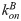
Relaxation kinetics of the AV-HABA complex and unlabeled biotin.The [HABA]/[B7] is the concentration ratio of these two ligands and the relaxation rate is in s-1 (Eq 3). The data points were fitted to a linear regression model yielding a slope and intercept of 0.0156 ± 0.0012 and 0.161 ± 0.005, respectively, resulting in a konB of 5.3 ± 0.9 × 106 M-1s-1 at 23°C. The additional values required for this calculation were HABA association constant to the 4th site when three HABA molecules are already bound: k1AV−HABA3 = 5.1 ± 0.1 × 105 M-1s-1 and the HABA dissociation of saturated AV-HABA4 complex: k−1AV−HABA4 = 6.23 ± 0.11 s-1. The corresponding KD
AV-HABA = 12.2 ± 0.3 × 10−6 M and is in excellent agreement with the 12 × 10−6 M reported by Green [60] at pH 8.